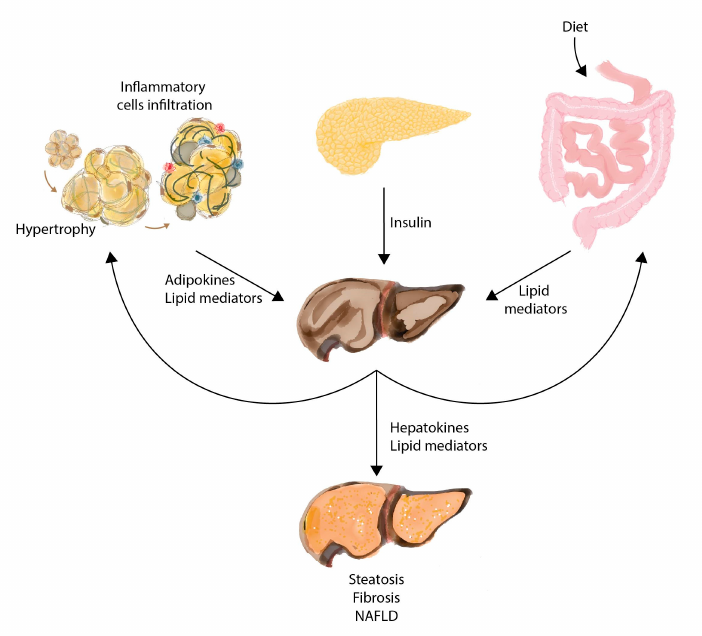
Figure 4. Lipidomics must consider the effect of interorgan crosstalk. Energy homeostasis is impor- tant in the health and disease of the liver and is highly dependent on metabolic signals derived from dietary intake or secreted from adipose tissue, gut, liver and all insulin-sensitive tissues.